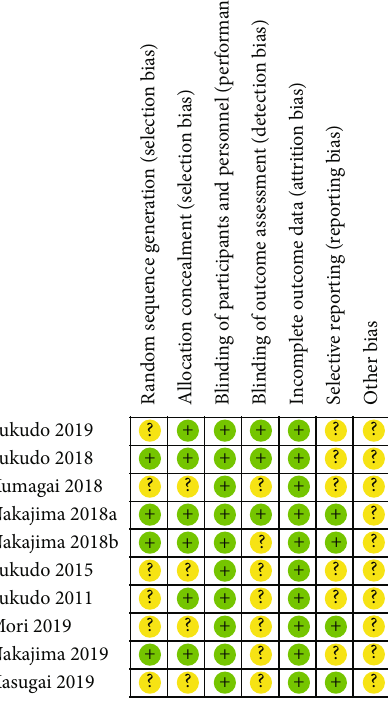
Figure 2: Risk of bias summary of reviewers ’ judgements for each risk of bias item for selected